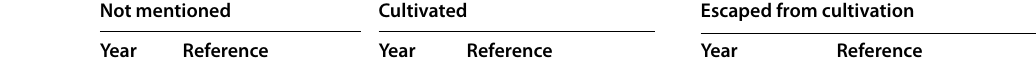
Table 6 Documented dates and regions where Hedychium gardnerianum was mentioned as cultivated or escaped from cultivation [Specimen number]. Lines within each region ordered by the year of column: Escaped from